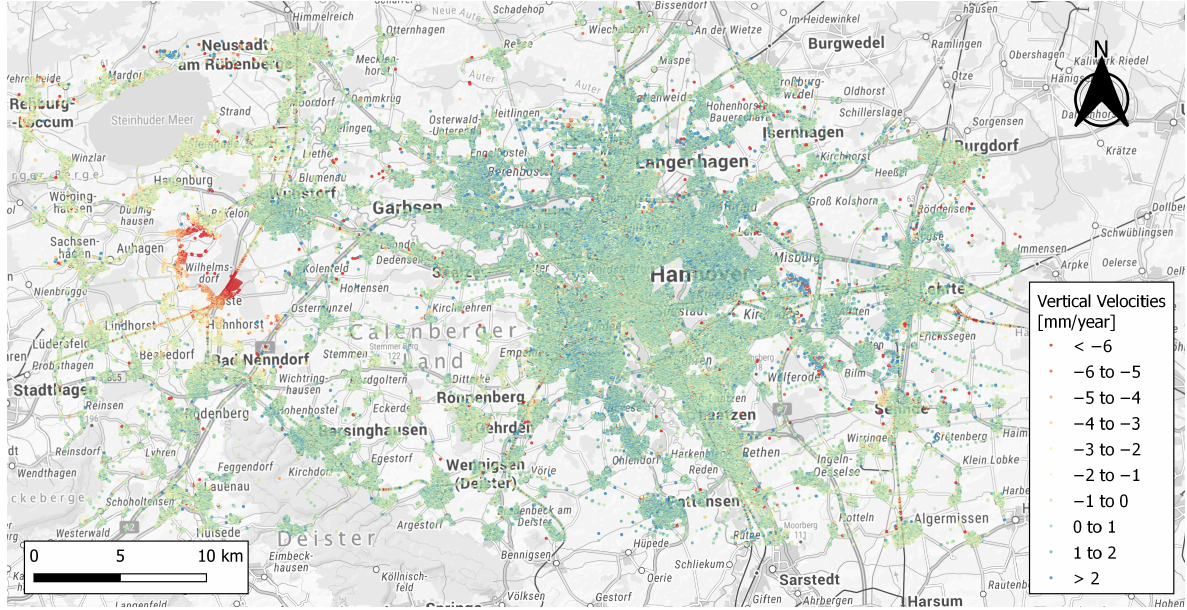
Figure 1. Provided velocity information in the Hanover area by PSI processing. The provided PSI information is corrupted by a high level of measurement errors. The measurement errors can be divided into two parts: noise and outliers. The noise in the data expresses the precision of the measured samples. By considering prior knowledge about the performance of the measurement system, this can be considered in the surface modeling